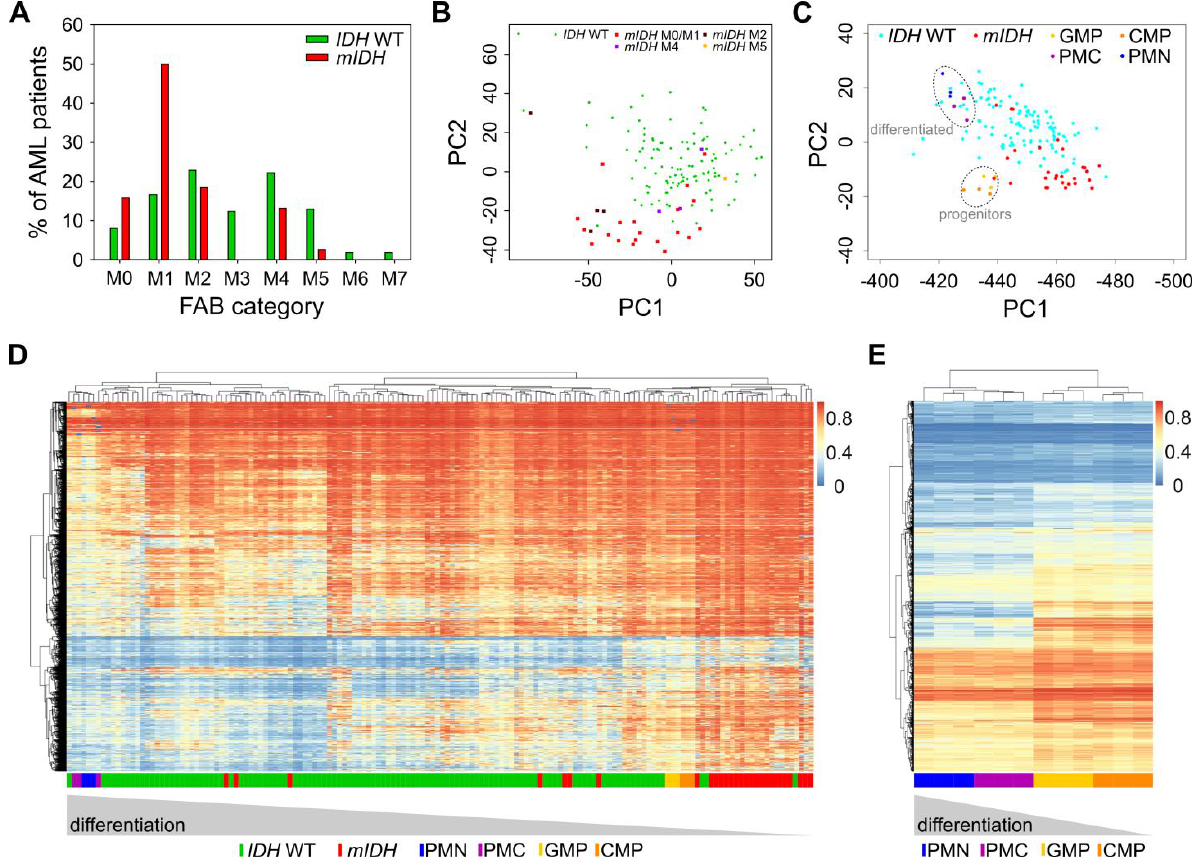
FIGURE 6: mIDH -associated hypermethylation reflects enriched hypermethylated hematopoietic progenitor populations rather than a pathological hypermethylator phenotype. (A) Analysis of the distribution of the French–American–British (FAB) categories assigned in the AML dataset from TCGA within the IDH WT and mIDH patient groups. (B) PCA as in Fig. 1A. Different FAB categories in the mIDH patient group are colored as indicated. Variances captured by PC1 and PC2 were 17.3% and 8.3%, respectively. (C) PCA with 450K profiles from sorted hu- man cells of four hematopoietic differentiation stages [38]. TCGA AML patient profiles of mIDH / IDH WT patients were projected on top of the clusters generated by analysis of the four cell types. CMP: common myeloid progenitor, GMP: granulocyte macrophage progenitor, PMC: promyelocyte, PMN: polymorphonuclear/terminally differentiated bone marrow neutrophil. (D) Heatmap of the 10,000 most differentially methylated probes between the CMP/GMP and PMC/PMN populations in the AML cohort of mIDH / IDH WT patients. Each row shows one probe and each column one patient. A hierarchical cluster dendrogram showing similarities between samples is depicted on the top. The color scale indicates beta values. (E) Heatmap and hierarchical cluster dendrogram of human hematopoietic cell types using the 10,000 most differentially methylated probes between mIDH and IDH WT AML patients. Each row shows one probe and each column one sample. The color scale indicates beta